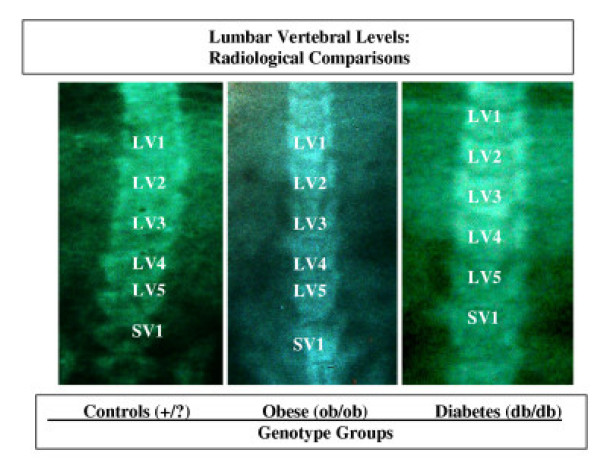
Radiological comparisons between the lumbar vertebral segments (LV 1–5) for control, obese (ob/ob) and diabetes (db/db) genotype-mutants groups are represented (x12.5) as indicators of length and width index parameters measured relative to the severity of diabetes-obesity syndrome aberrations for body weight and systemic endocrine/metabolic (Table 2) indices.